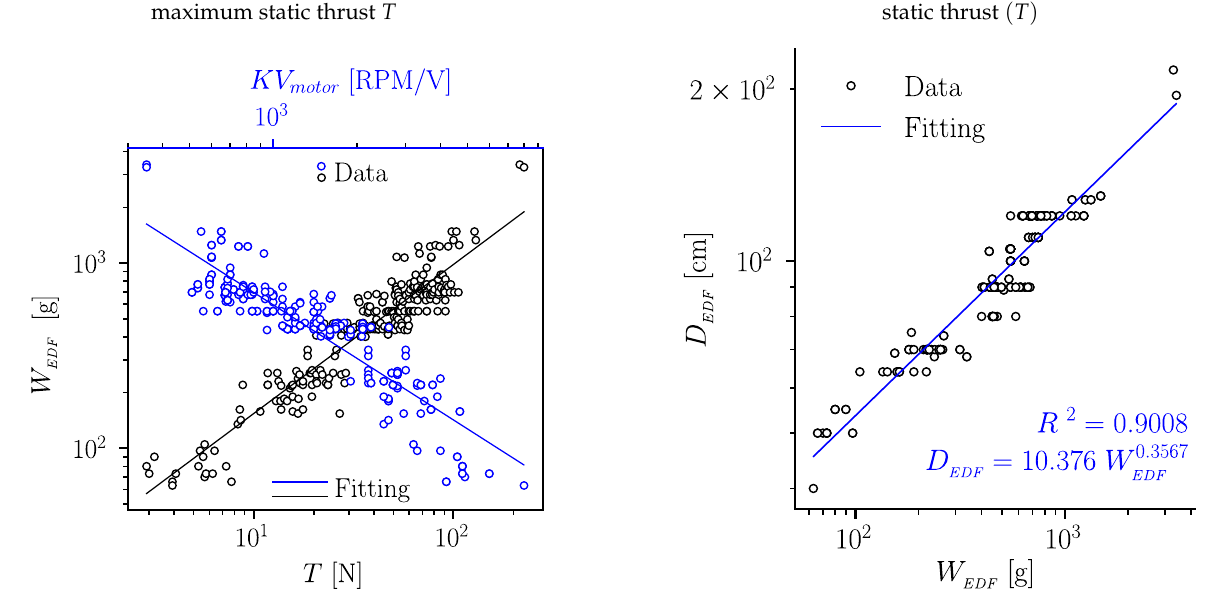
Figure 5. Sizing correlations for EDFs from 2 to 250 [N] of maximum static thrust. n = 270